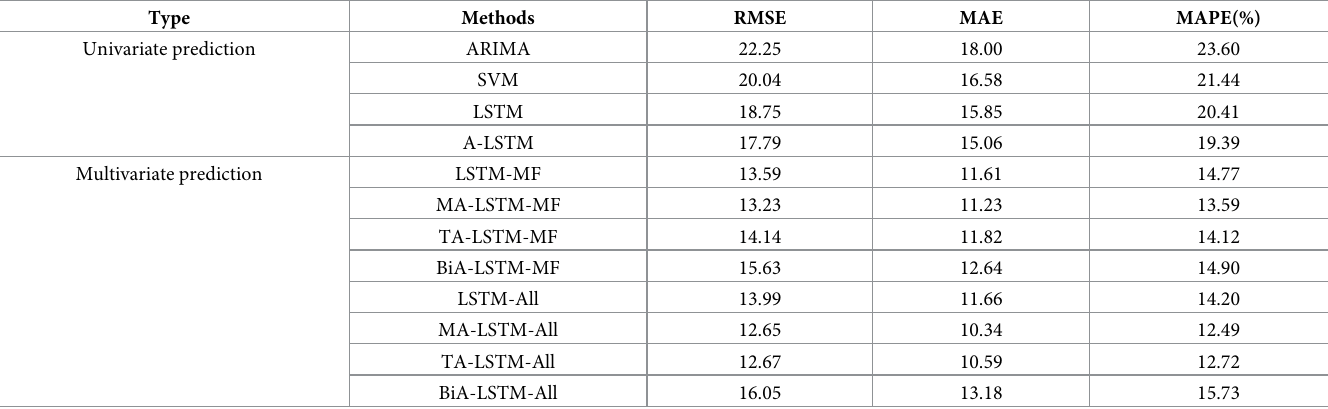
Table 2. Prediction results of hepatitis E cases by all the models.